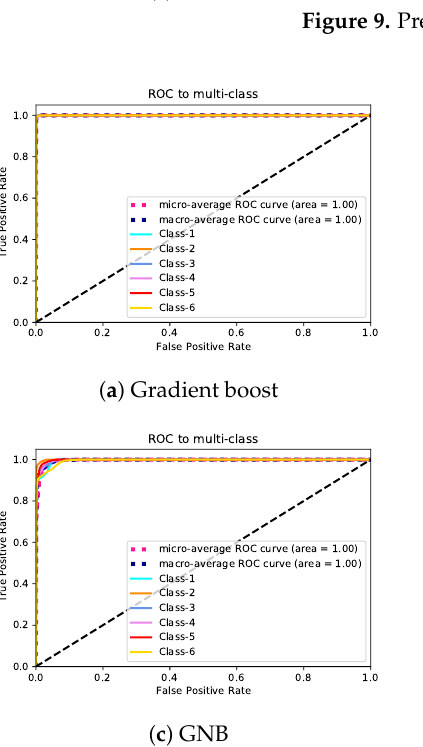
Figure 9. Precision–recall curves for Exp-II.